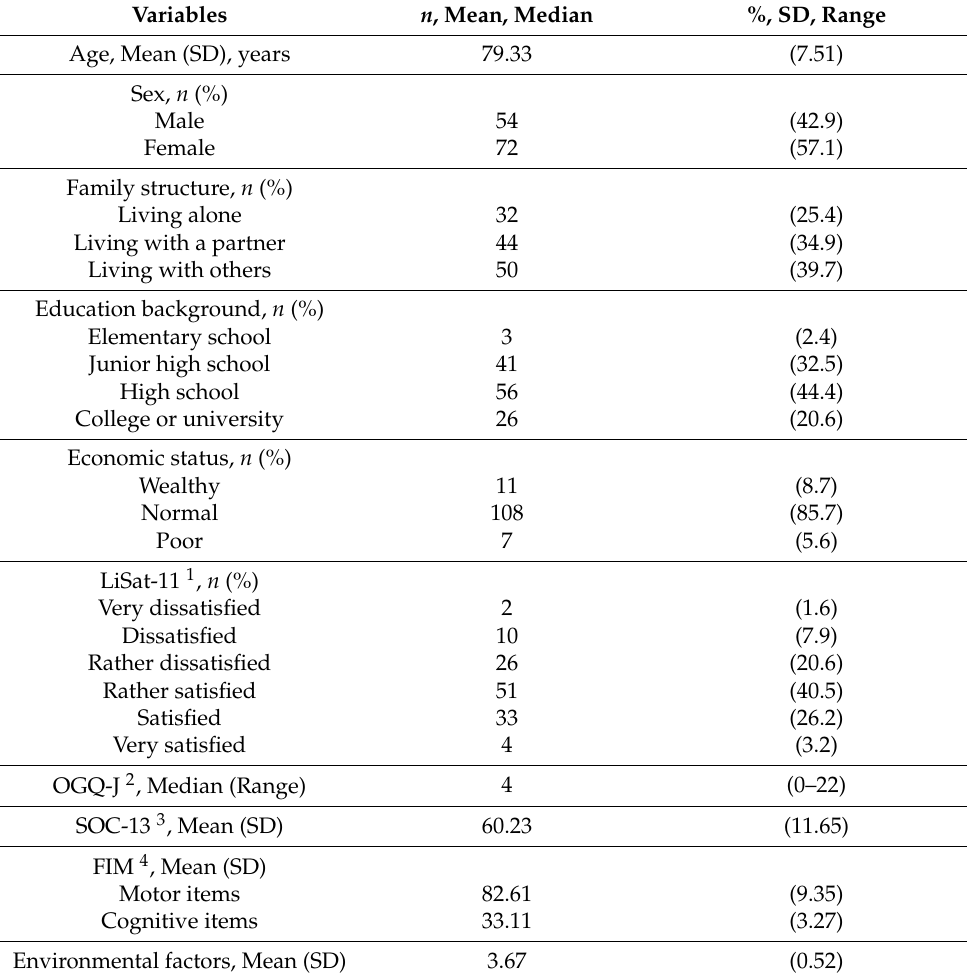
Table 1. Characteristics of the study participants ( n =